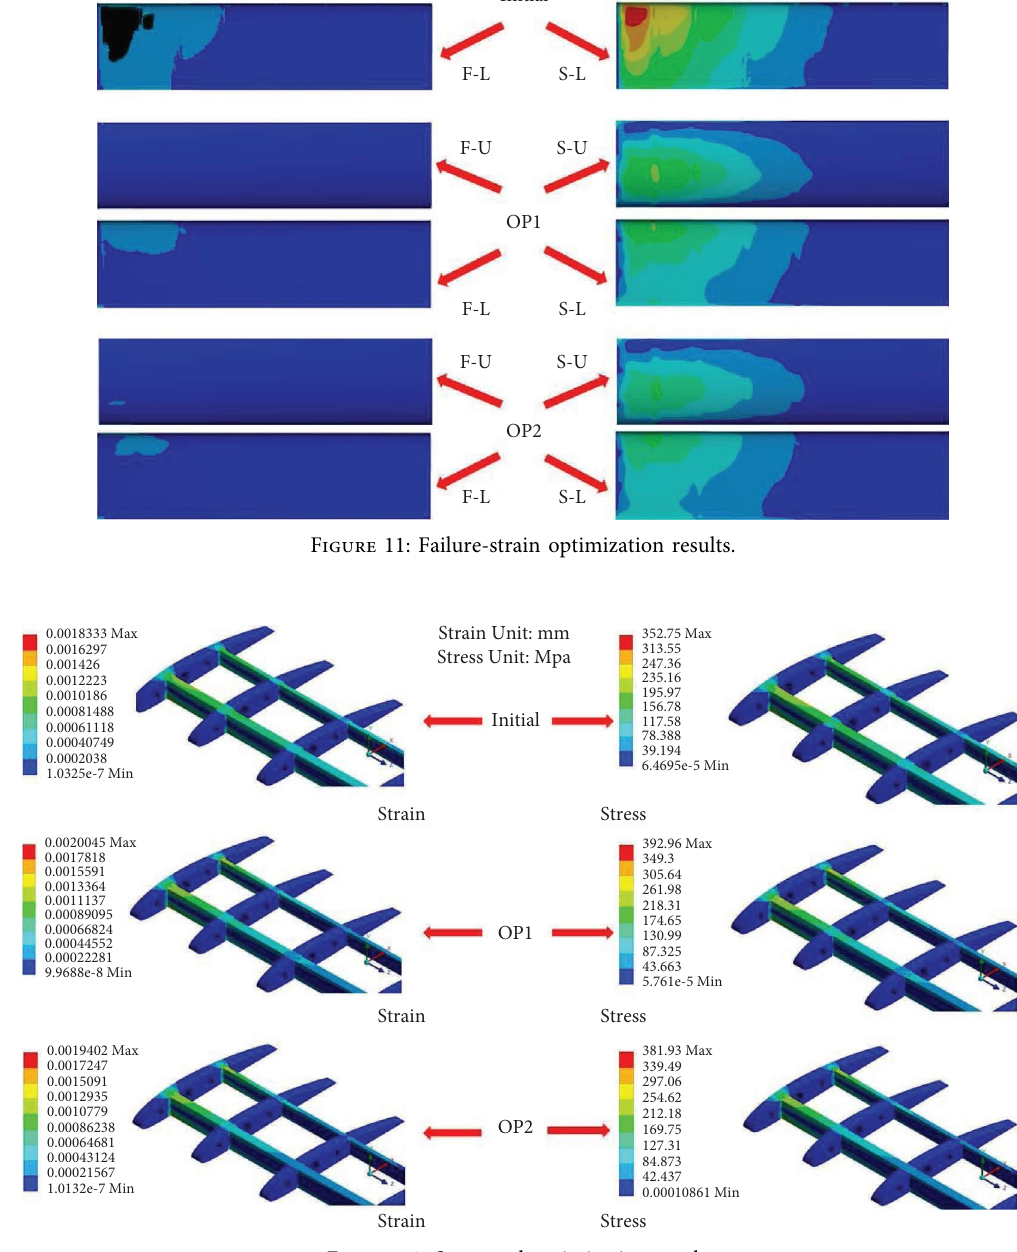
Figure 12: Structural optimization